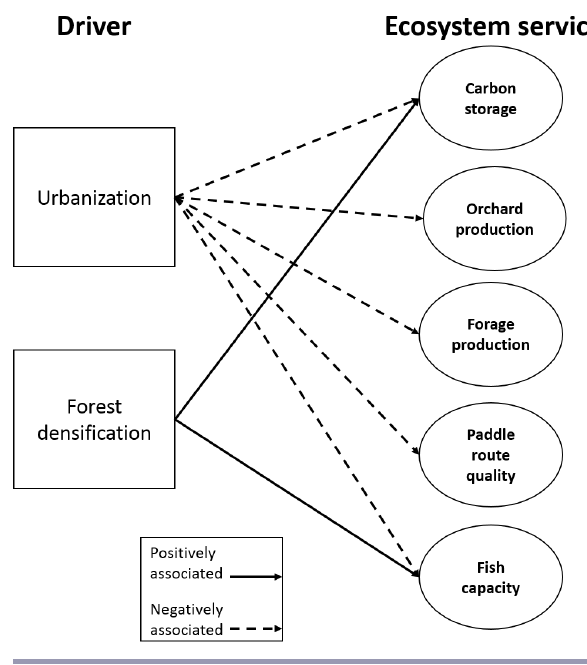
Fig. 6 . Primary drivers of change in the Wenatchee system floodplain and their impacts to ecosystem services. Our approach links land cover, river-floodplain characteristics, and other spatial data to map ecosystem services. Changes in landscape attributes resulting from forest densification and urbanization played an important role in driving ecosystem service interactions. Ecosystem services are likely to interact through their shared links to land